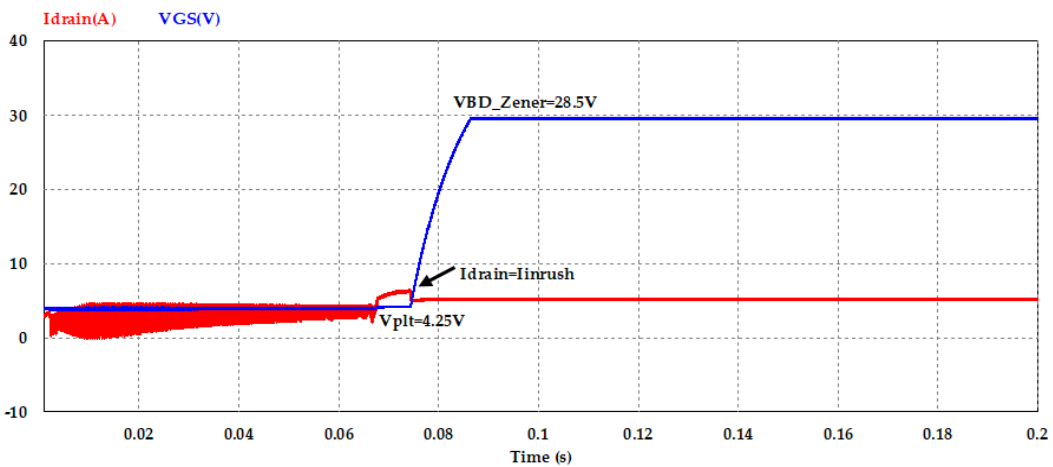
Figure 14. Gate charge waveform of the MOSFET in inrush current mitigation circuit.